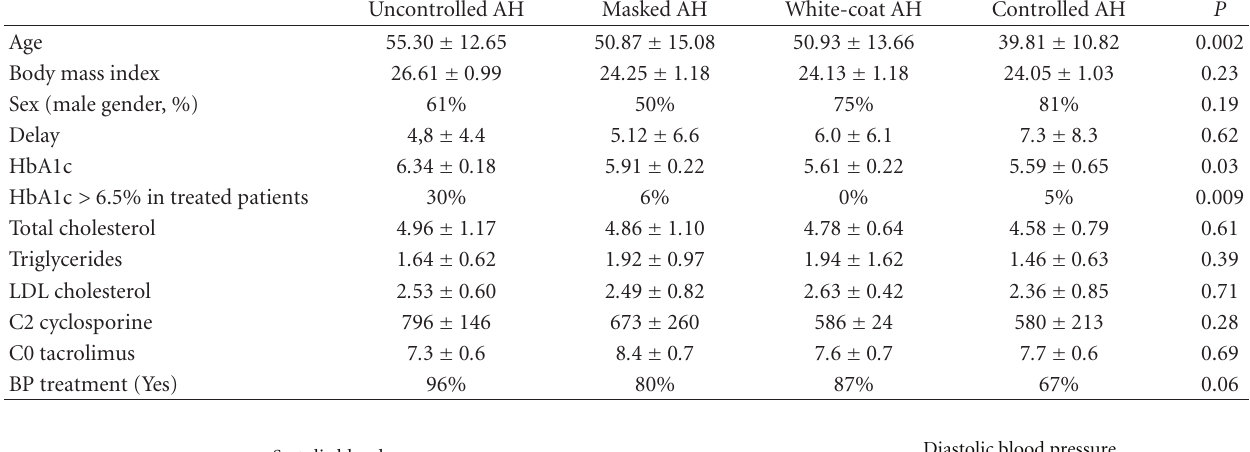
Table 3: Patients characteristics classified by threshold of BP normality by measurement methods (AH: arterial hypertension).